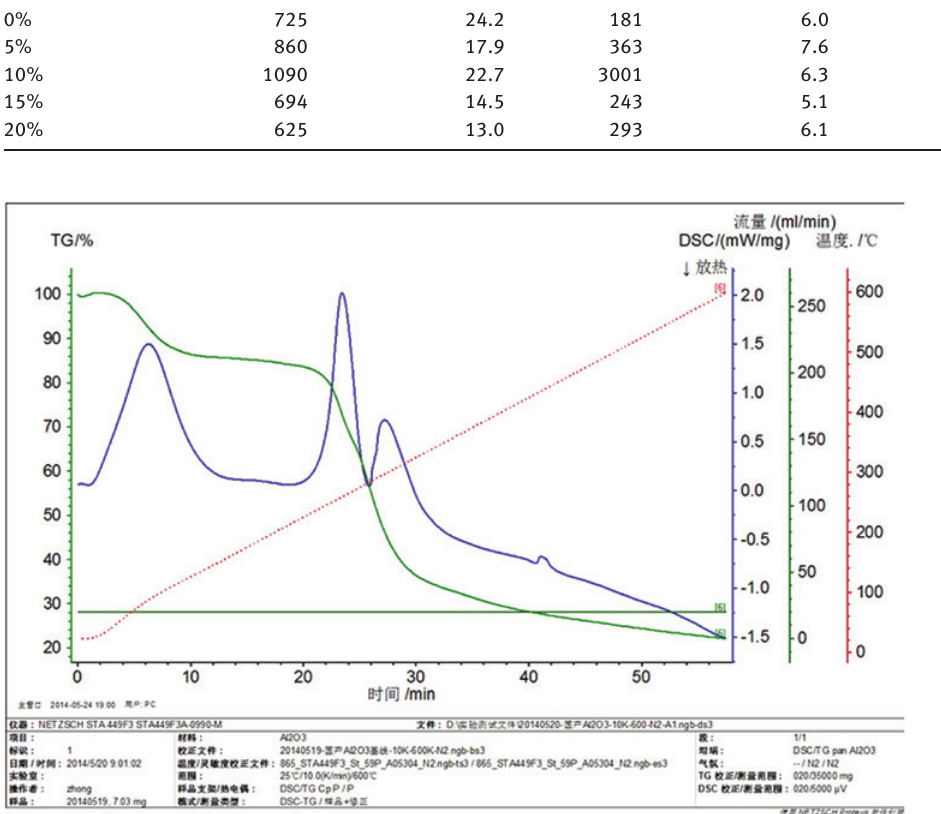
Table 6: Mechanical properties of epoxy matrix with different content of nanocapsules. Samples (content of